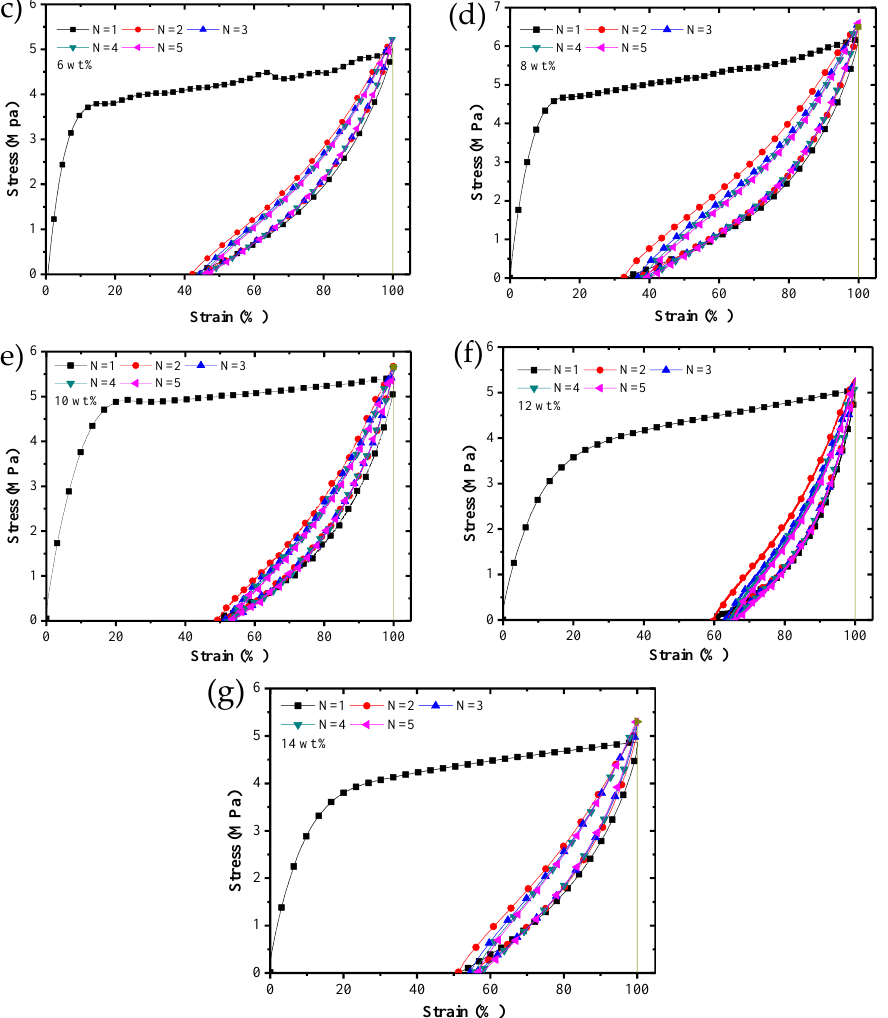
Figure 11. The stress–strain curves of SMP composite specimens with carbon fiber mass fraction of ( a ) bulk, ( b ) 4 wt %, ( c ) 6 wt %, ( d ) 8 wt %, ( e ) 10 wt %, ( f ) 12 wt % and ( g ) 14 wt % under 5 constant strain cycles at room temperature.